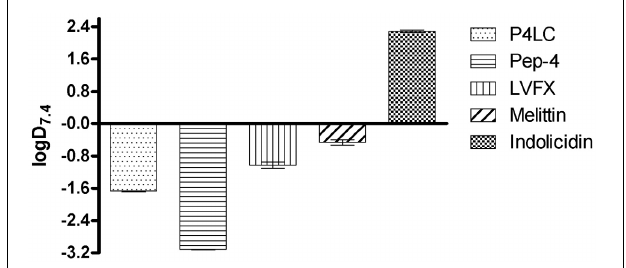
FIGURE 6 | Experimentally determined logD 7 . 4 values for P4LC, Pep-4, LVFX, melittin, and indolicidin.